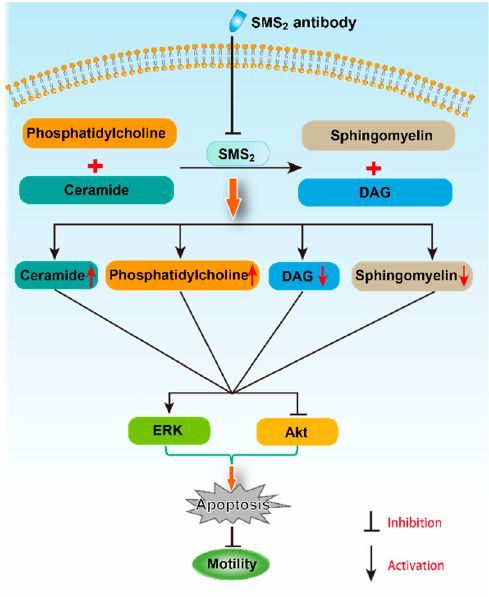
Figure 8. The possible mechanism for the effect of SMS2 on sperm motility.